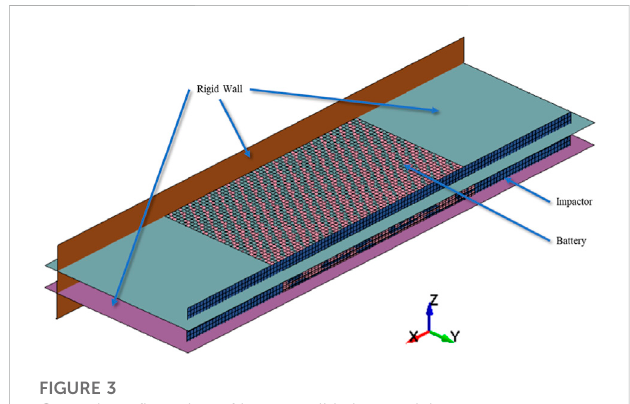
General con fi guration of battery validation model.